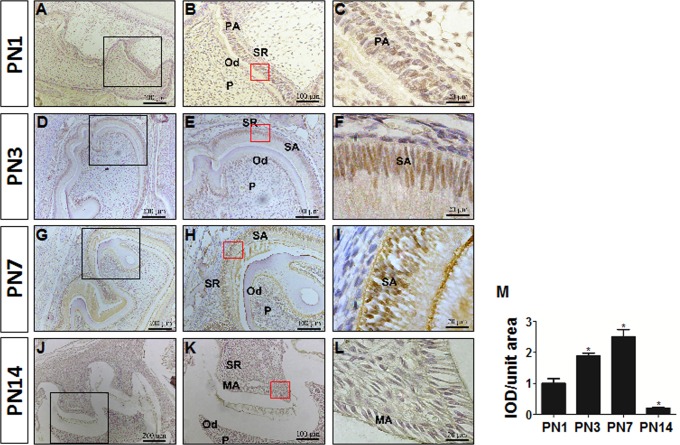
Immunostaining of DLX3 protein at different stages of mouse amelogenesis.(A-L) Immunostaining of DLX3 in sections of mouse molar germs at postnatal days 1 (A-C), 3 (D-F), 7 (G-I), and 14 (J-L). Representative figures from three independent experiments are shown. (M) The immunoreactivity of DLX3 protein within ameloblast cells was expressed as the mean optical density of the ameloblasts [integrated optical density (IOD)/unit area]. Each bar represents mean ± SD. *P <0.05 vs. the control (PN1 group). A, D, G, and J, original magnification ×100; B, E, H, and K, high-power magnification of the boxed areas in the low-magnification images, original magnification ×200; C, F, I, and L, high-power magnification of ameloblasts from the area inside the boxes in B, E, H, and K, original magnification ×1000. PA, pre-secretory ameloblasts; SA, secretory ameloblasts; MA, maturation ameloblasts; Od, odontoblast; P, dental pulp; SR, stellate reticulum layer. PN, postnatal day.